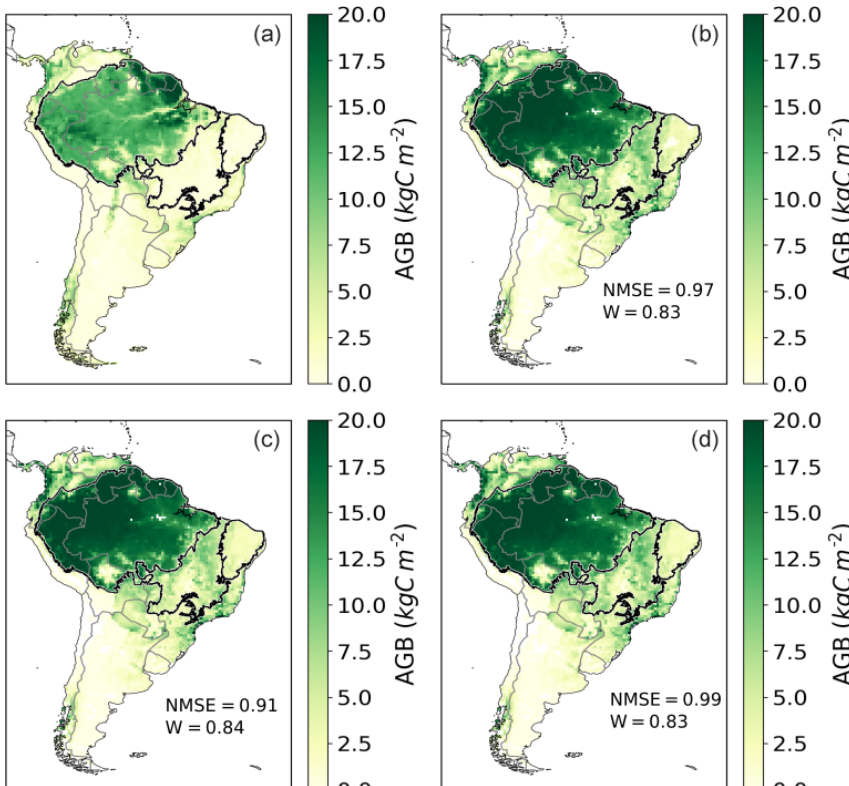
Figure A5. Annual aboveground biomass (AGB) of trees over a mean from 2005 to 2015 in kgCm − 2 . (a) Avitabile evaluation data. (b) Simulated AGB by LPJmL4-SPITFIRE in the NI orig version. (c) Simulated AGB by LPJmL4-SPITFIRE in the VPD optim version. (d) Simulated AGB by LPJmL4-SPITFIRE in the NI optim